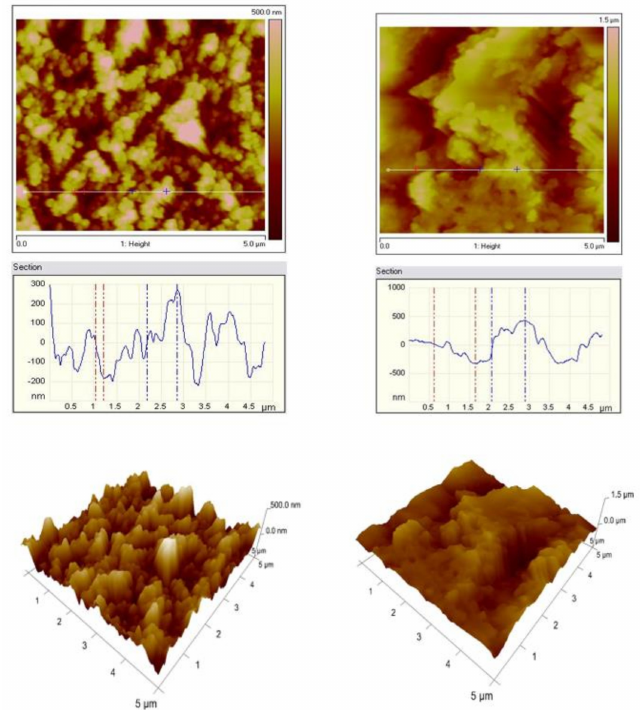
Figure 2. 2D and 3D topography of samples T25 ( left ) and T100 ( right ). Table 1. AFM analyses of the roughness of the coatings. Roughness